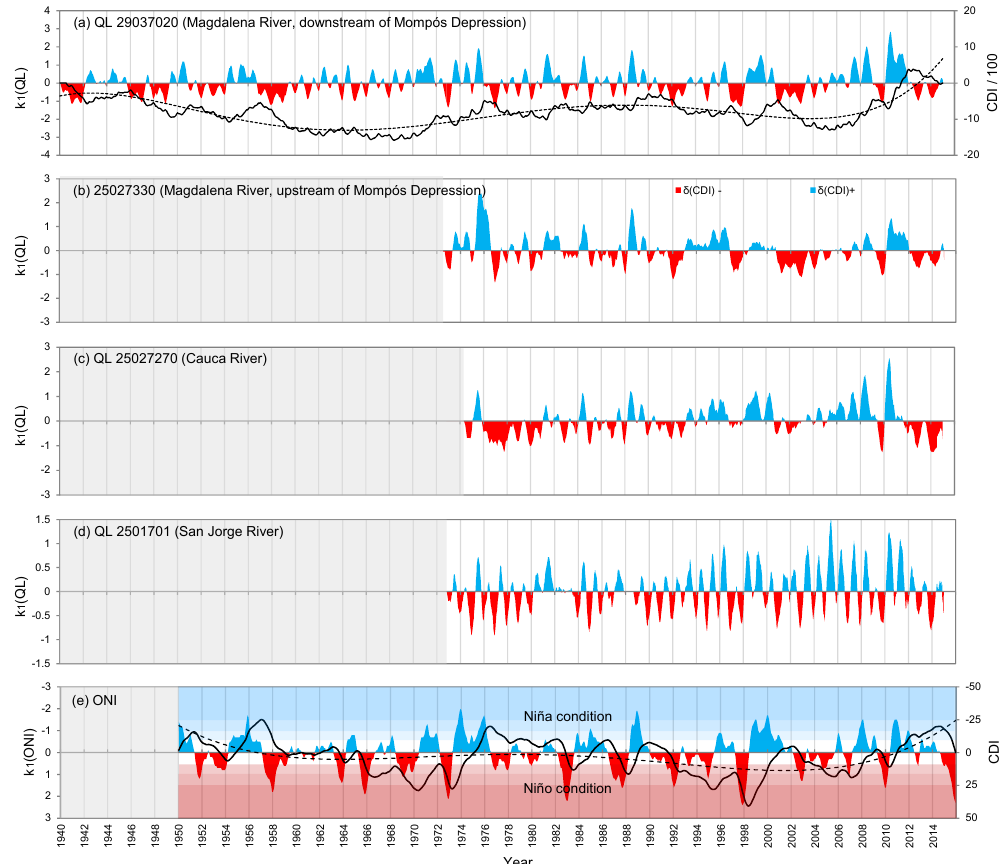
Figure 2. Streamflow inter-annual variability, expressed as the 6-month moving average of the k 1 anomaly (blue and red areas) and the corresponding cumulative anomaly (continuous black line) observed at streamflow (QL) gauges (a–d) in comparison to the Oceanic Niño Index (ONI; e ). Data gaps are shaded